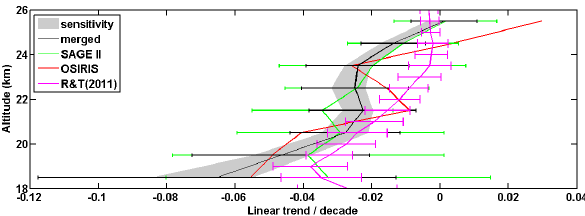
Fig. 4. Decadal trend profile in the 0 ± 4.5 ◦ latitude band for the merged data set (1984–2012, blue line) using the best regression model at each height. The 95% CI is shown as the error bar. At 25.5km, the best regression model does not include a linear trend term (see Fig. 3). To illustrate that the magnitude of the linear trend becomes statistically insignificant at 25.5km, the linear trend term was added to the best regression model for 25.5km. The grey area illustrates the sensitivity of the linear trend vertical profile for the merged data set to the regression model terms, tested by applying best regression models (see Fig. 3 and Table 1) to different altitudes to generate trend profiles. The grey area shows the standard devi- ation (1 σ) about their median trend. Trends from OSIRIS (2001– 2012) with error bars omitted (see text), SAGE II (1984–2005), and Randel and Thompson (“R&T (2011)”) are also